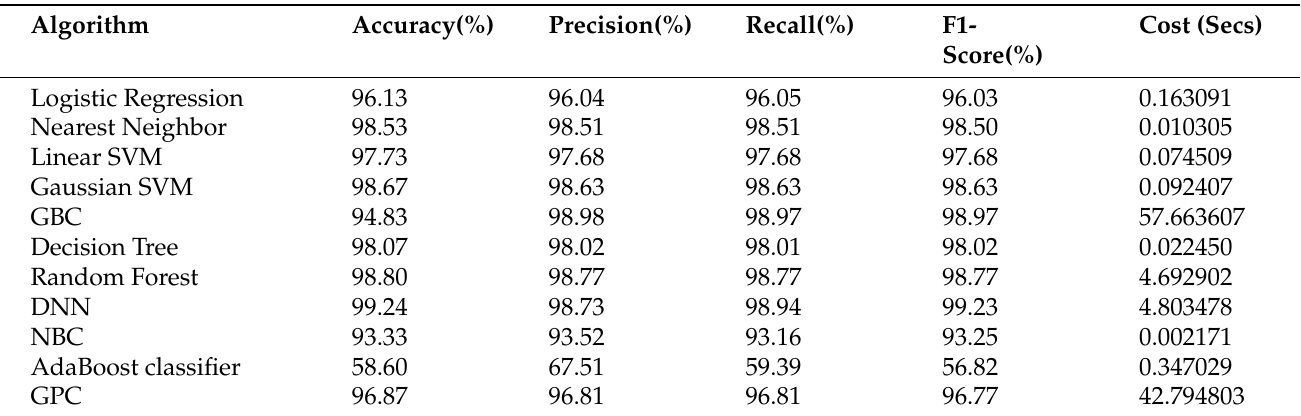
Table 6. Diagnostic performance comparison of ML